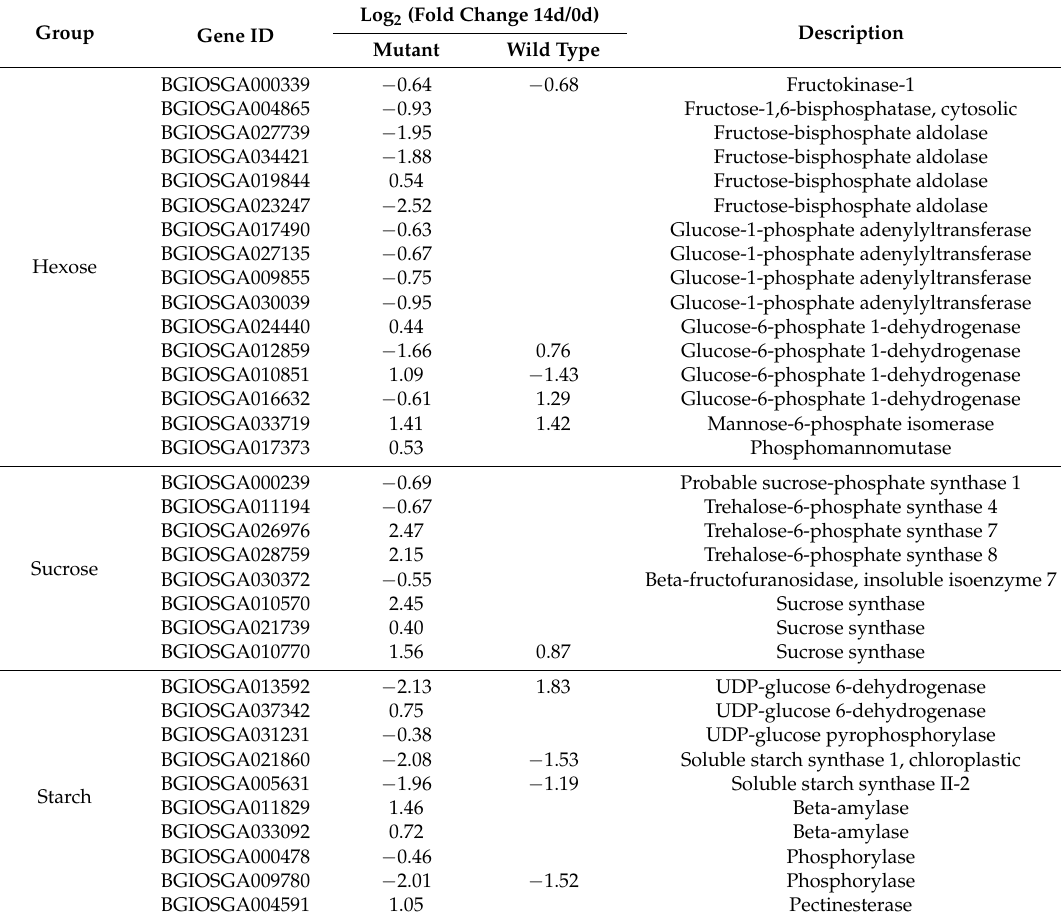
Table 8. Genotypic differences in expressions of DEGs associated with carbohydrate metabolism between the initial and 14th day of the grain-filling stage (padj <